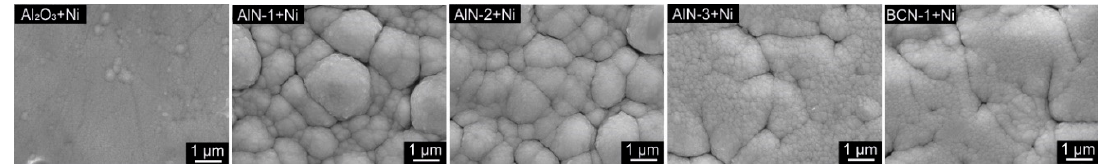
Figure 5. SEM images of the topography (top) of the Ni thin films deposited on a polished Al 2 O 3 substrate as well as on AlN and BCN thin films.